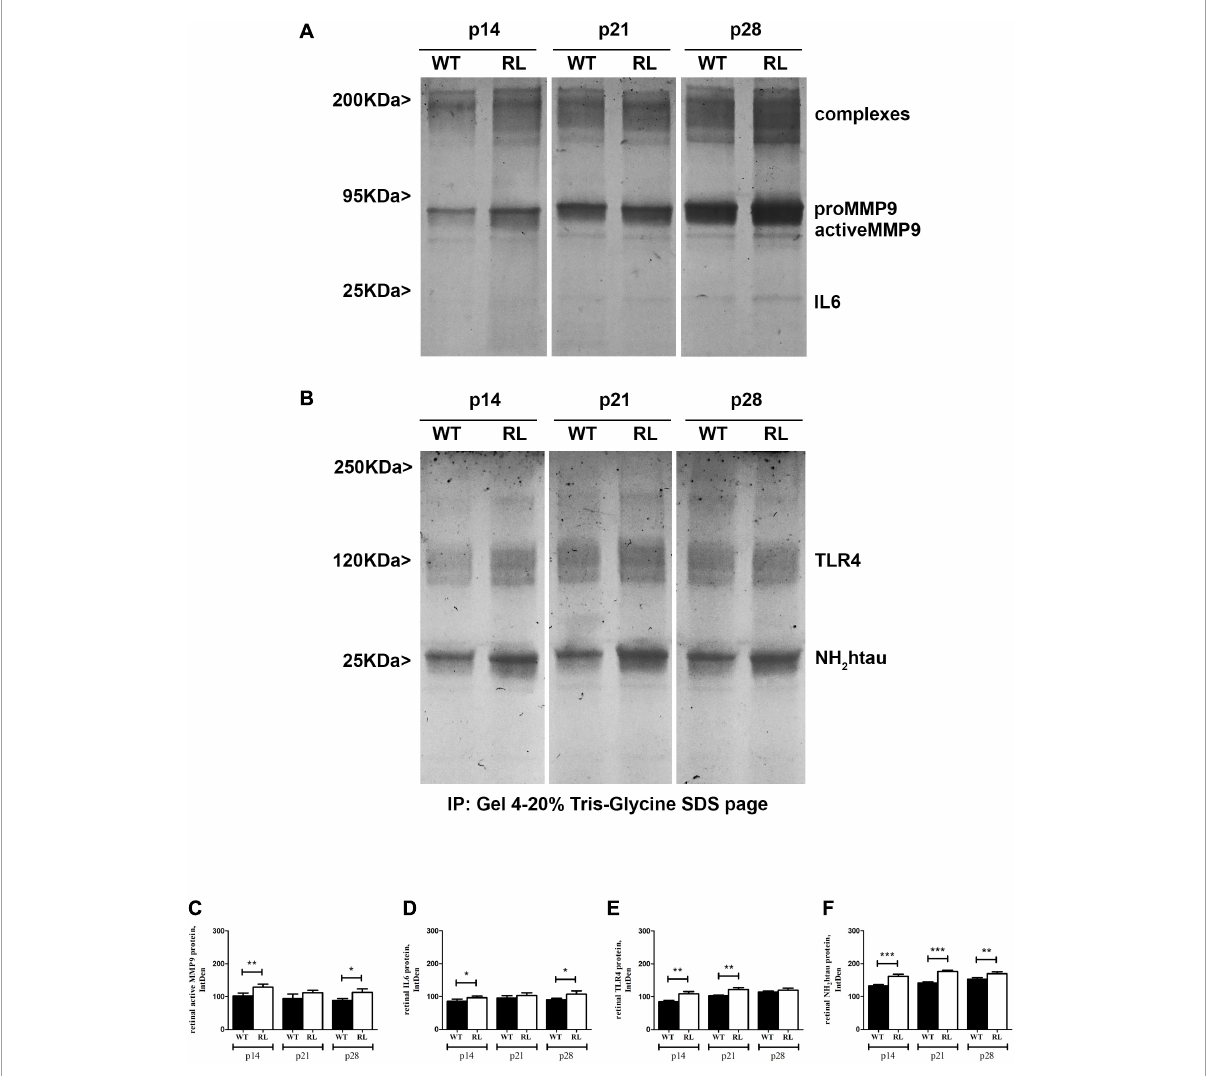
FIGURE7 Representative immunoblots (4–20%) and relative densitometric analysis of control (WT) and Reeler (RL) retinal protein extracts, as probed and quantified: MMP9 (A,C) ; IL6 (A,D) ; TLR4 (B,E) and NH 2 htau (B,F) antibodies (IntDen values; * p < 0.05, ** p < 0.01, *** p < 0.005; Kruskal Wallis analysis with post Dunn’s multiple comparison test analysis). The proteins were normalized against β -actin; the original re-probed β -actin immunoblot is shown in Supplementary Figure 2